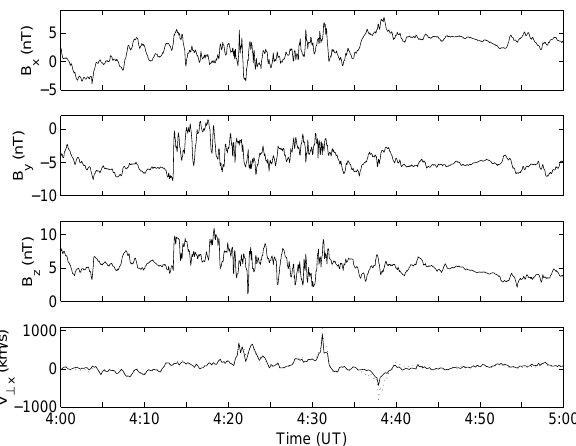
Fig. 3. GEOTAIL spacecraft 4 February 1998 observations of (a) B x , (b) B y , (c) B z magnetic field traces in GSM coordinates. (d) The V x component of velocity (dotted) and the V x ⊥ cross magnetic field component